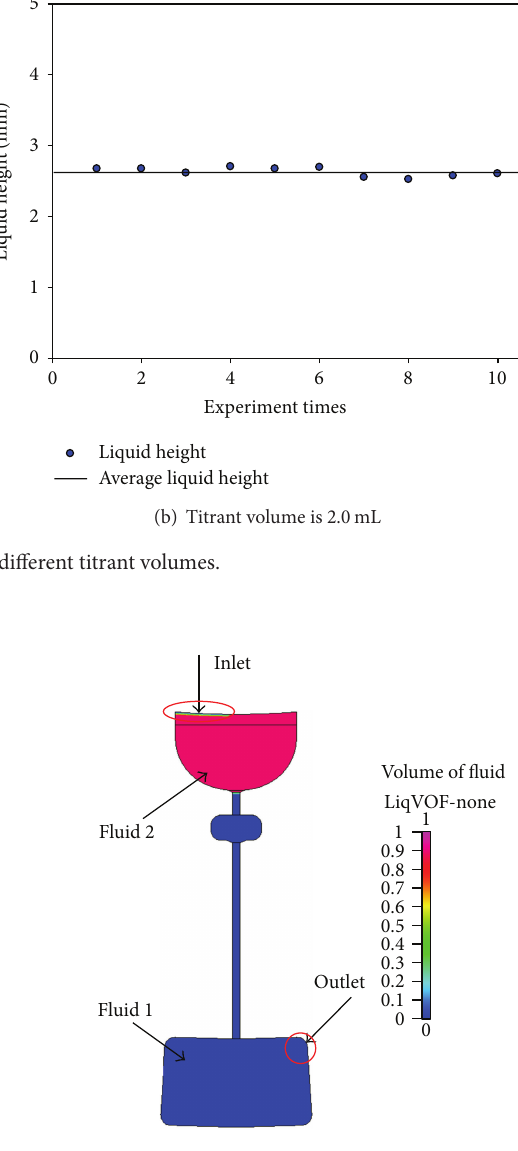
Figure 11: Analysis of simplified simulation